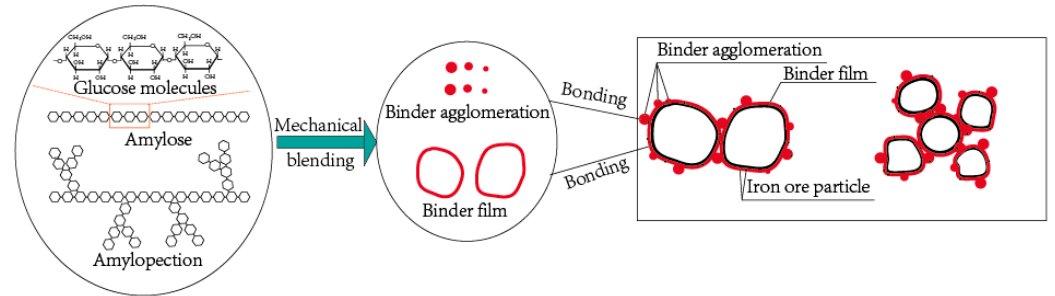
Figure 18. Schematic diagram of the binder bonding the iron particles through binder film and binder agglomeration.